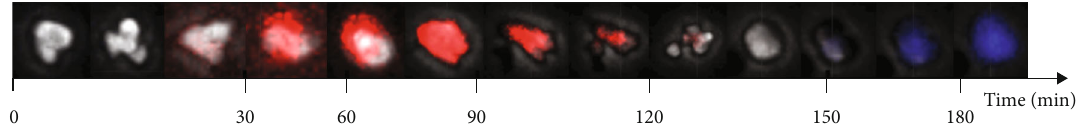
Figure 6: Live cell imaging: time fl ow in min of a PMN treated with fMLP and H7 showing chemotaxis (phase-contrast), oxidative activity (red, rhodamine-123, staining reactive oxygen species (ROS)), and suicidal NETosis (blue, DAPI, staining PMN – DNA